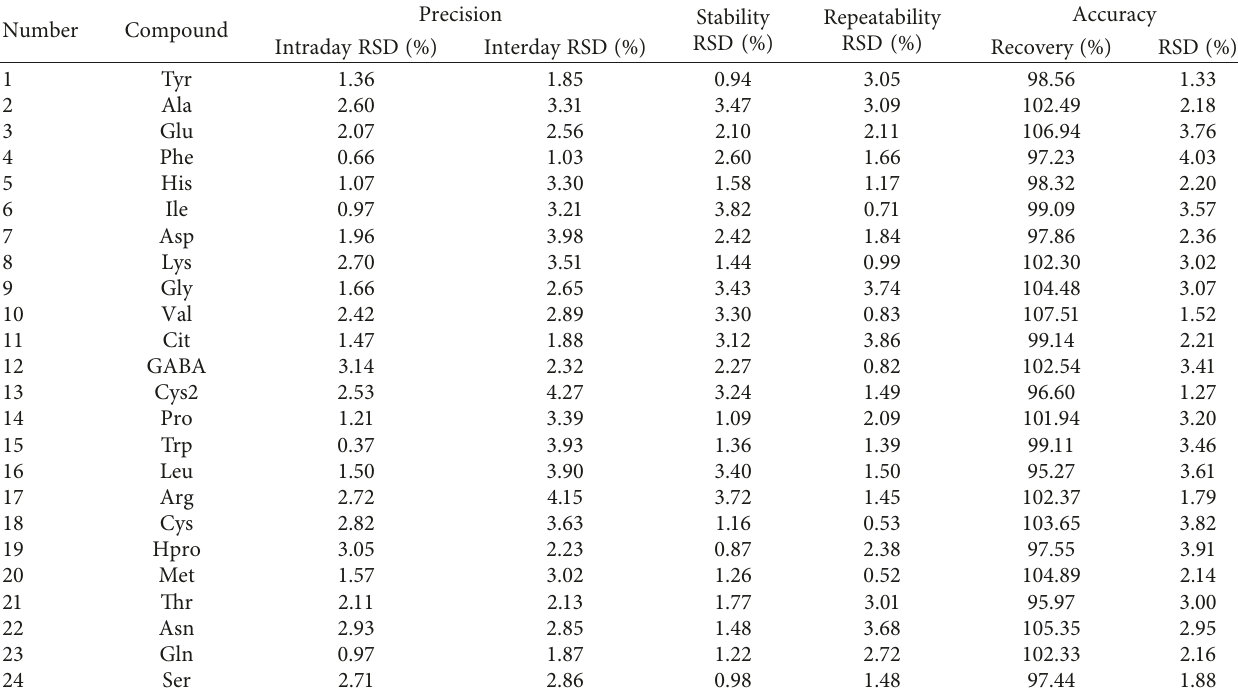
Table 4: Precision, stability, repeatability, and accuracy of the investigated analytes ( n �